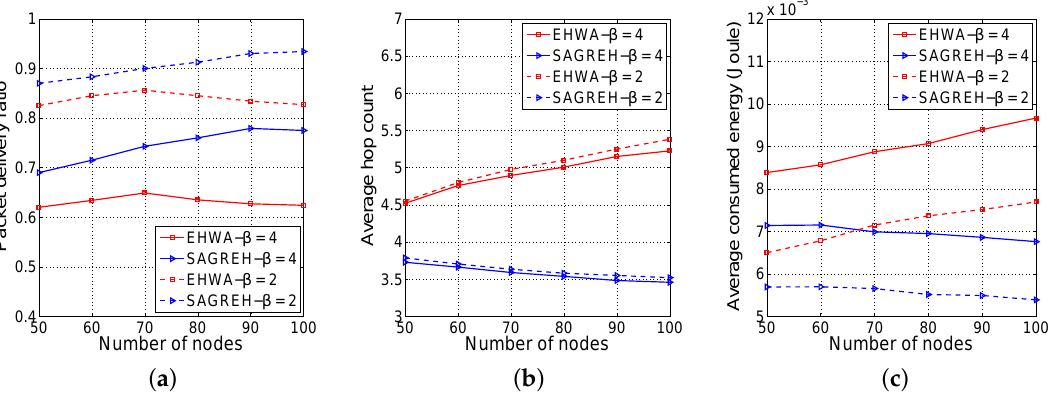
Figure 7. ( a ) The PDR, ( b ) average hop count, and ( c ) average energy consumption as a functions of the number of